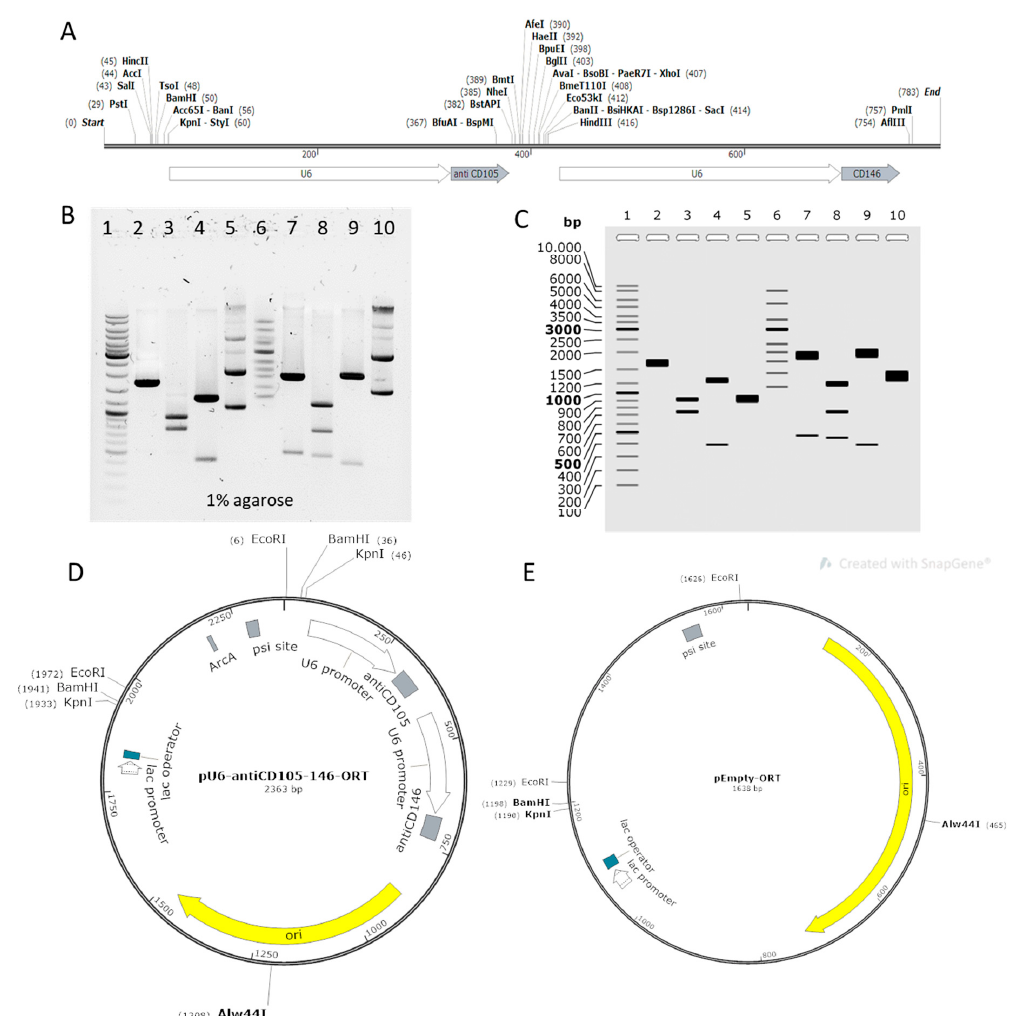
Figure 1. Construction of plasmids. ( A ) Assembly of the expression cassette encoding CD105 and CD146 shRNAs, each under its own U6 promoter. ( B ) Electrophoresis on 1% agarose gel stained with SybrSafe and run 1 h in TAE buffer at 100 V. ( C ) Restriction analysis simulation based on predicted sequence. Lane 1: GeneRuler™ DNA Ladder Mix; lane 2: